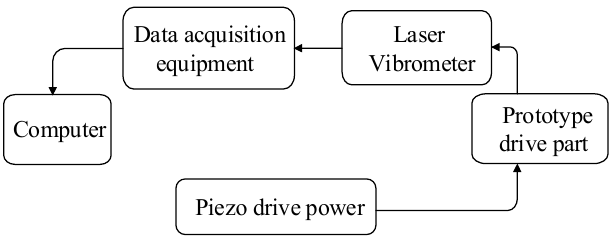
Figure 12. Flow chart of the free vibration test system.